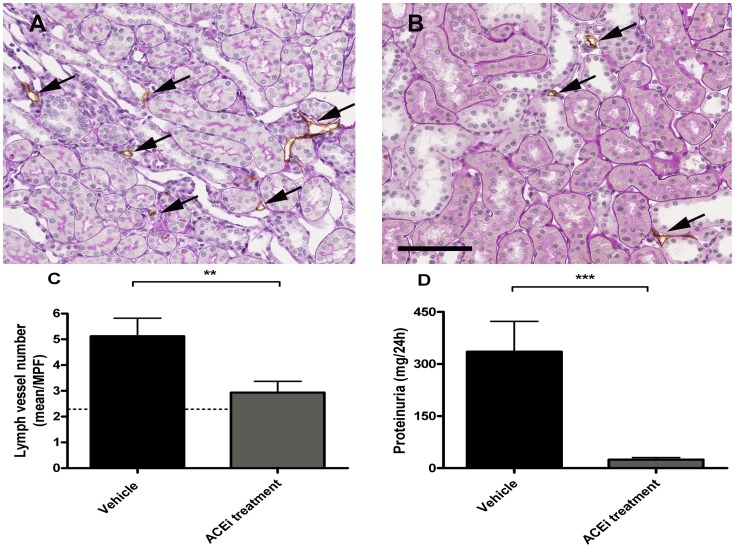
Antiproteinuric intervention strongly prevents renal lymphangiogenesis.Lymphatic vessel number was significantly higher in the kidneys of proteinuric rats than in rats receiving anti-proteinuric treatment. Representative images of interstitial lymphatic vessels (arrows) in the kidney of proteinuric (A) compared to treated animals (B). Quantification showed a significant reduction of lymph vessel number upon anti-proteinuric treatment (C), whereas efficacy of ACE inhibition on proteinuria is shown in D. Dashed line shows the mean number of cortical lymphatic vessels in kidneys of healthy rats. (Bar = 100 µm, **p<0.01, ***p<0.001).